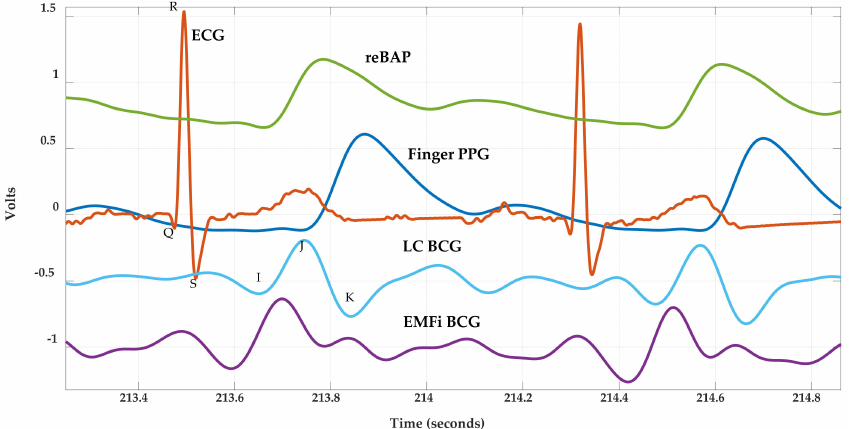
Figure 7. Various cardiopulmonary waveforms and their associated features. The reconstructed brachial artery pressure (reBAP) waveform acquired by a Finapres Finometer PRO ® is scaled at 100 mmHg/volt. The BCG signals were scaled/shifted vertically and preprocessed as described in Section 2.4. ECG and PPG data are collected with a GE Datex Ohmeda CardioCap 5 patient monitor.